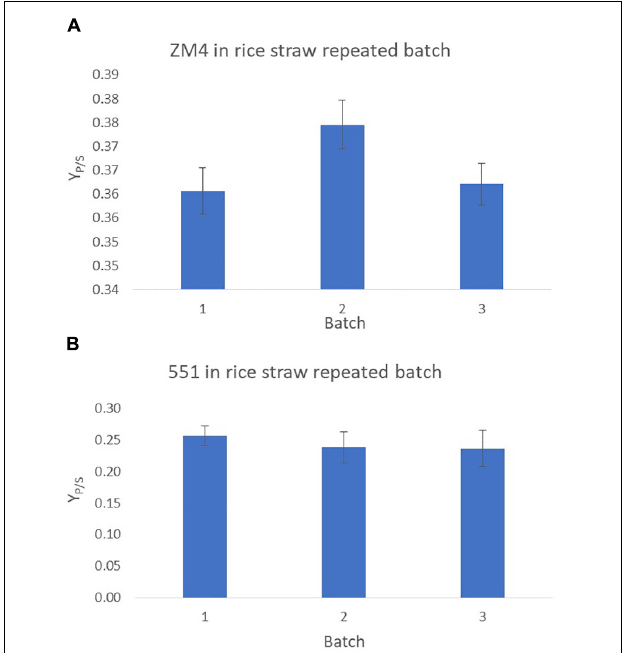
FIGURE 5 | Repeated batch fermentation of biofilms for Z. mobilis strains ZM4 (A) and TISTR 551 (B) in rice straw hydrolysate. This was processed in a total of three consecutive batches. The experiments were performed in triplicate and the data were statistically analyzed using ANOVA.